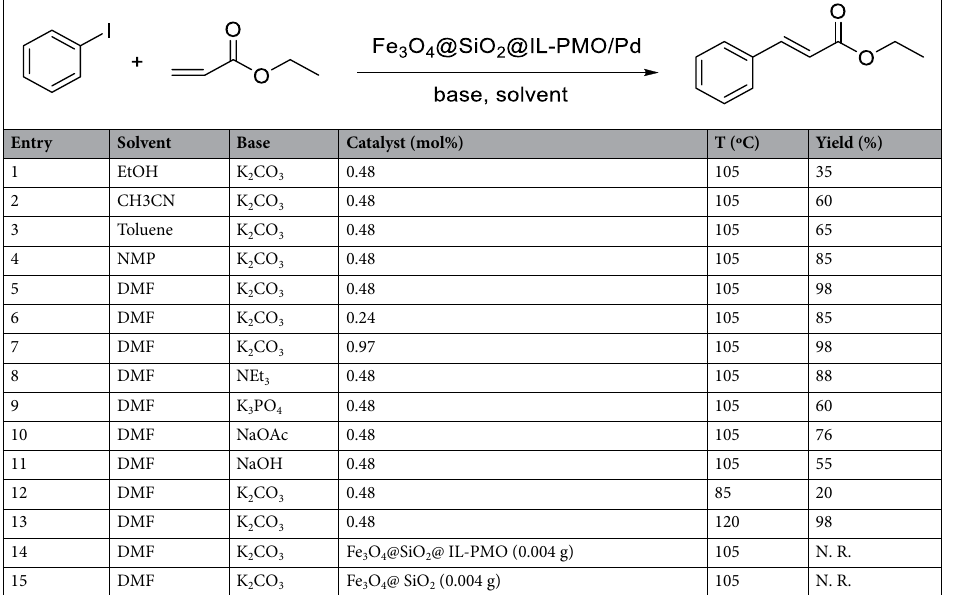
Table 1. Screening different parameters in the Heck